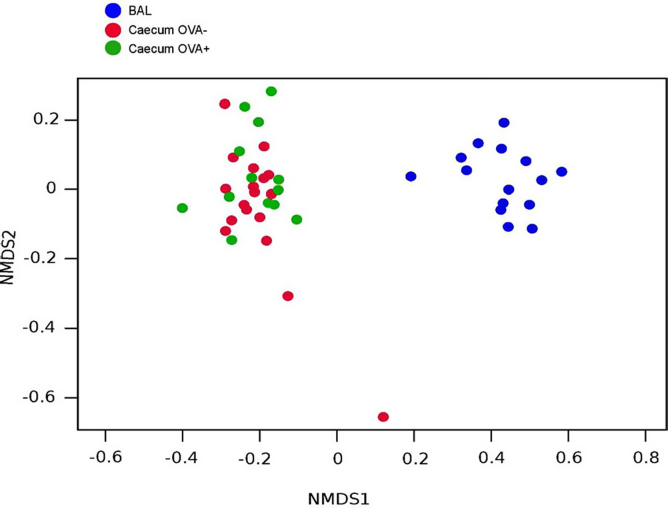
Microbial community clustering among experimental groups. Fig. 3 shows a non-metric multidimensional scaling (NMDS) plot of the beta diversity of all the individual samples regardless of genotype. There is a strong statistical significant dissimilarity between BAL (Blue n = 16) and caecum samples (Red n = 16 and Green n = 18) using the Anoism test (R = 0.898, p = 0.001). There is also a statistical significant difference between caecum samples from OVA treated animals (Green) and non-challenges animals (Red) (R = 0.100, p = 0.038).